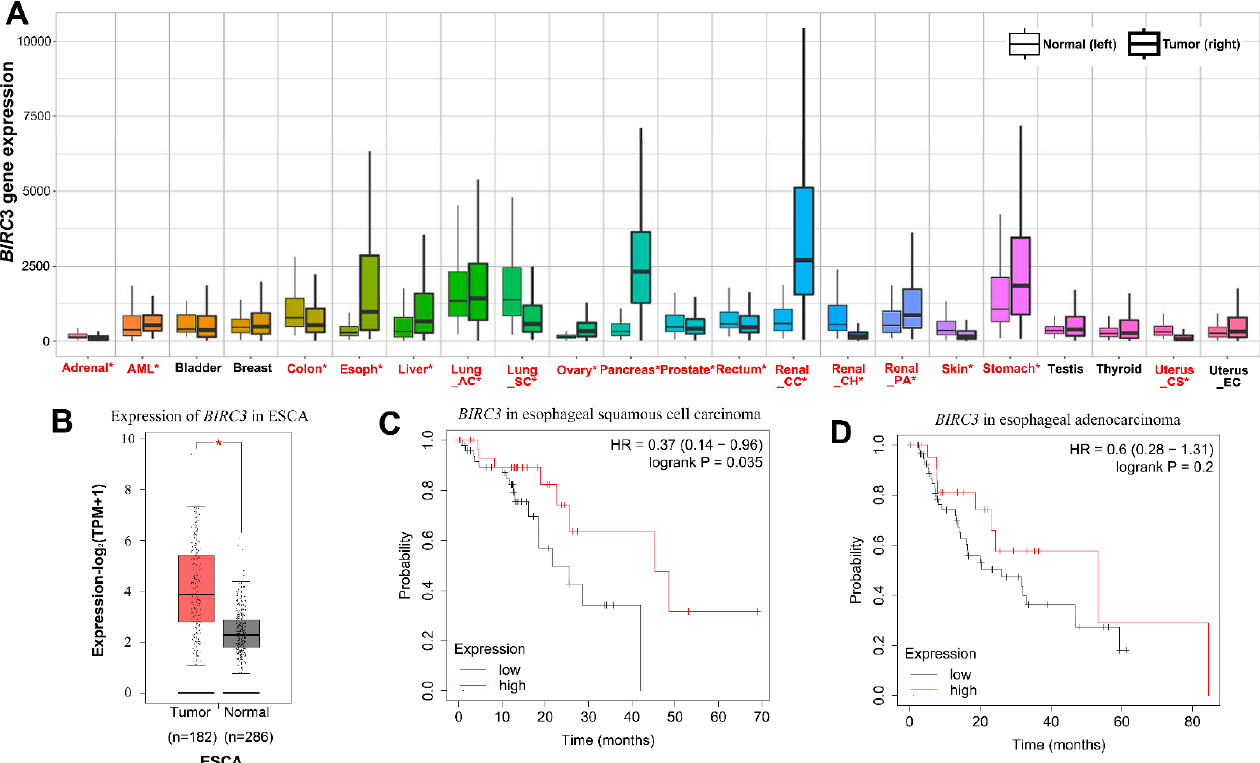
Figure 1. In silico analysis of expression levels of BIRC3 in normal and tumor tissues: ( A ) TNMplot analysis of BIRC3 expression profiles. The cancers with significant differences in gene expression of BIRC3 are marked with red color and asterisk. ( B ) Expression levels of BIRC3 in esophageal cancer. The analysis was performed by the multiple gene comparison program of the GEPIA2 database. ( C , D ) Kaplan–Meier Plotter analysis of BIRC3 in esophageal squamous cell carcinoma and esophageal adenocarcinoma, respectively. The red line indicates the overall survival rate with high levels of BIRC3 , and the black line shows the low levels of BIRC3 in esophageal cancer. In silico analysis of expression levels of BIRC3 in normal and tumor tissues.